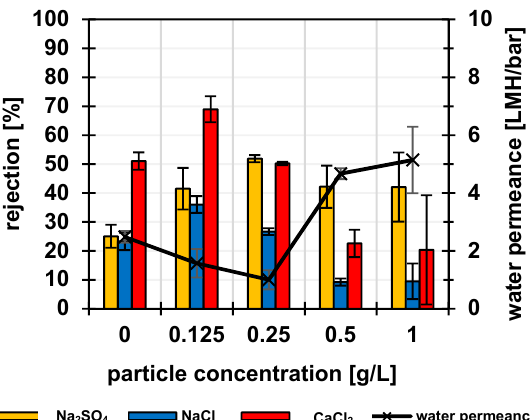
Figure 5. Influence of the variation of PSSA particle content in ethanol used for coating the porous PES support membrane onto the water permeance and rejection of single salts. The PEI and GDE contents were 0.5 g/L and 1 g/L, respectively.